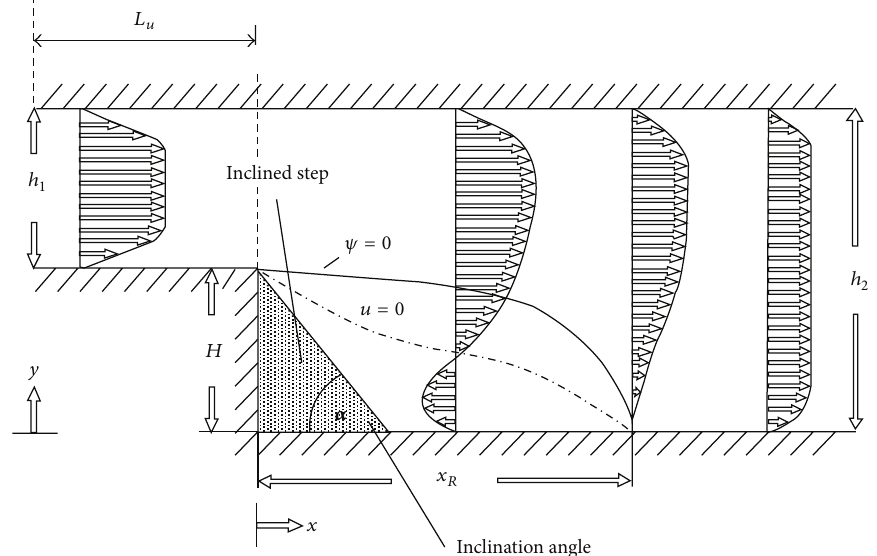
Figure 2: Backward facing step with variable step